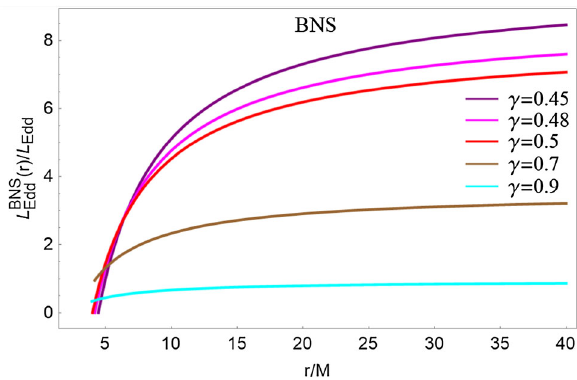
Fig. 12 Comparison of Eddington luminosity of EBWH and BNS for relevant values of γ on a logarithmic